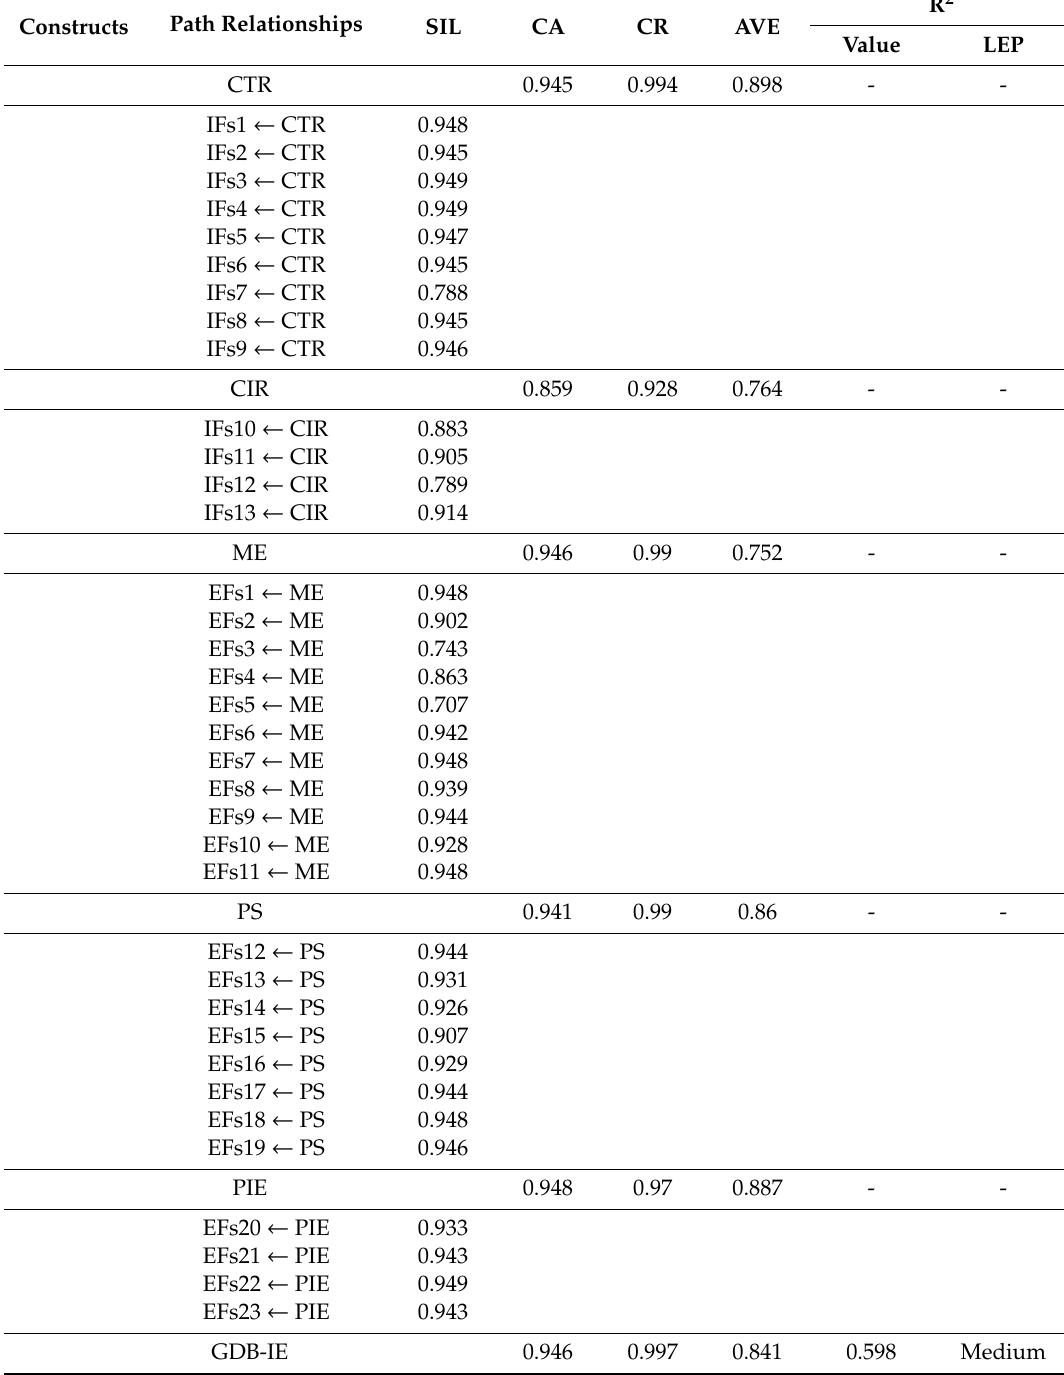
Table 3. Reliability, convergent validity and R 2